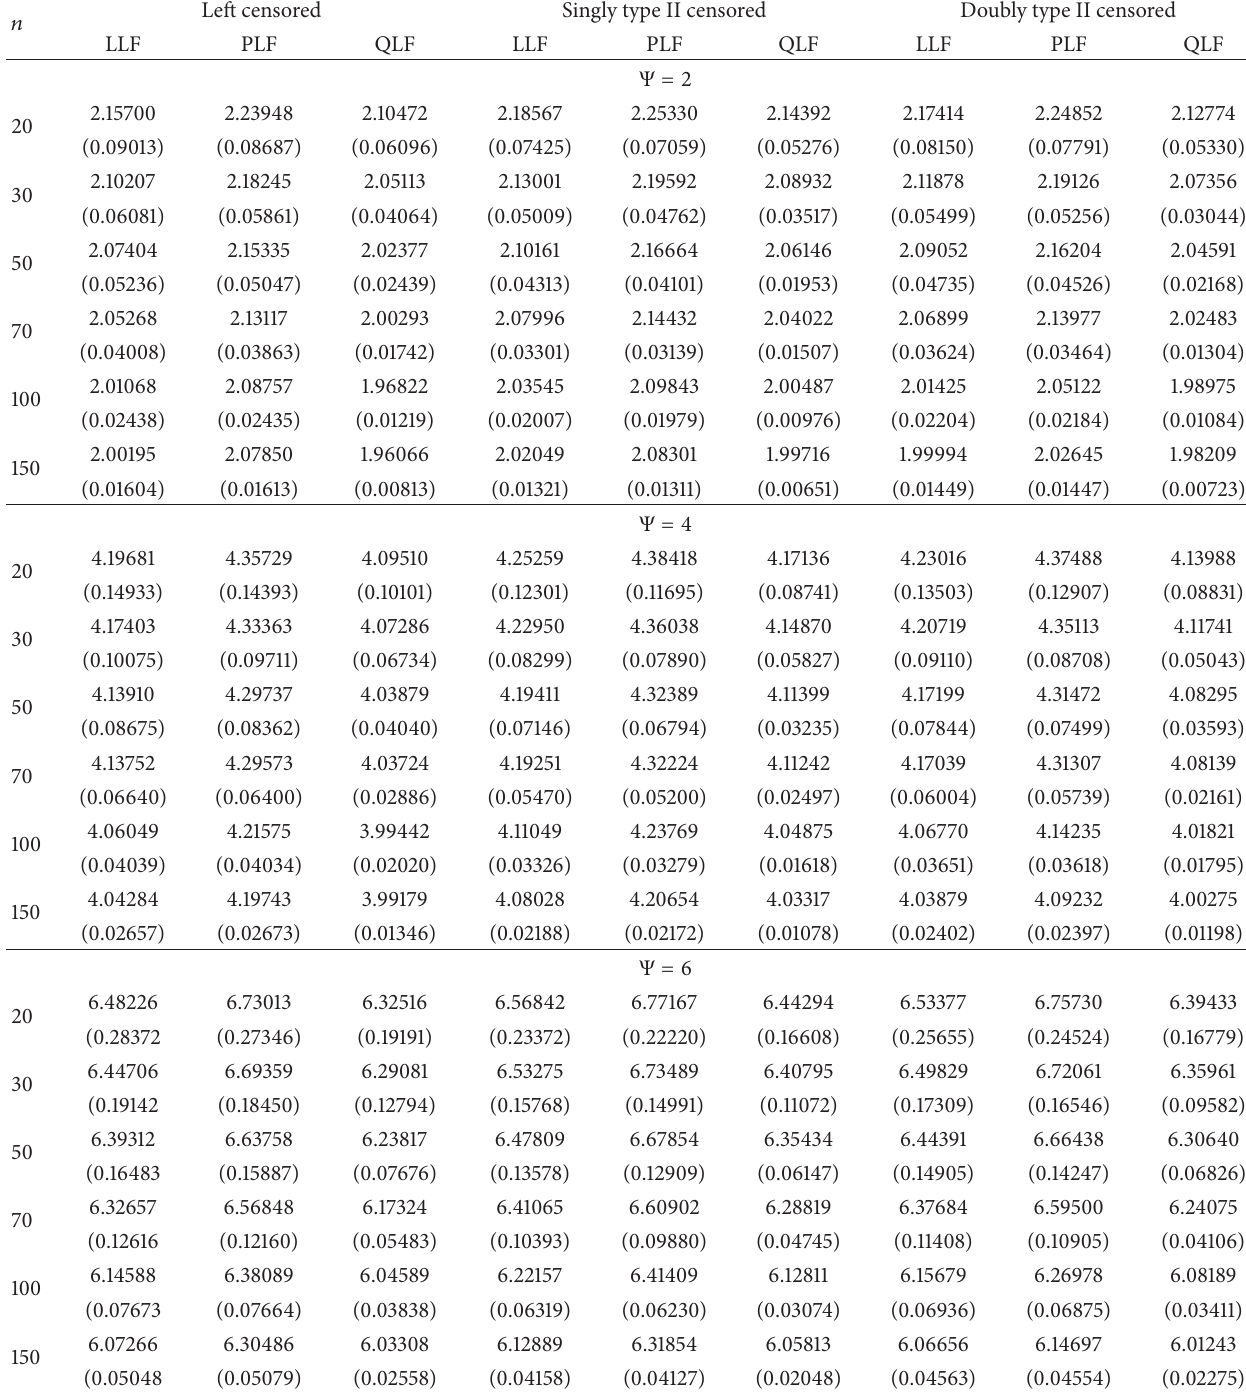
Table 2: Bayes estimators and posterior risks under Jeffreys